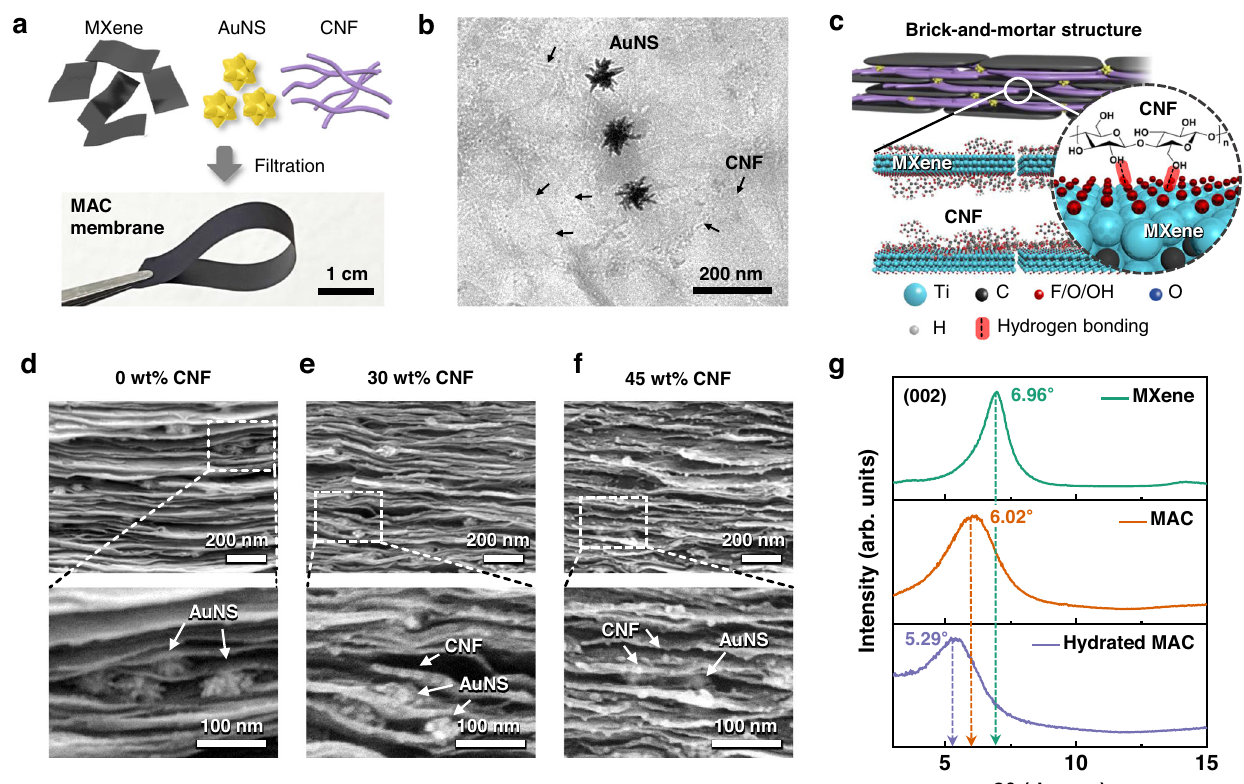
d 0wt%, e 30wt%, and f 45wt% CNFs. g XRD spectra of MXene, the MAC, and the hydratedMACmembrane.MXene(20mg)andMAC(7wt%ofAuNSsand35wt%of CNFs in 20mg of MXene) were utilized for the XRD spectra. The MAC membrane was soaked in DI water overnight for the preparation of the hydrated MAC mem- brane. Source data are provided as a Source Data fi